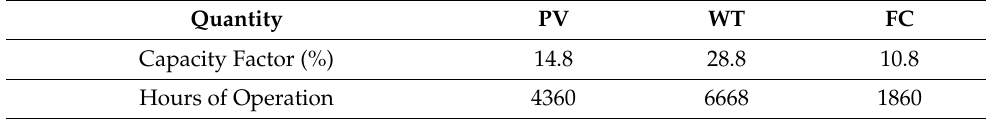
Table 16. Power generation and operation time for each power source in